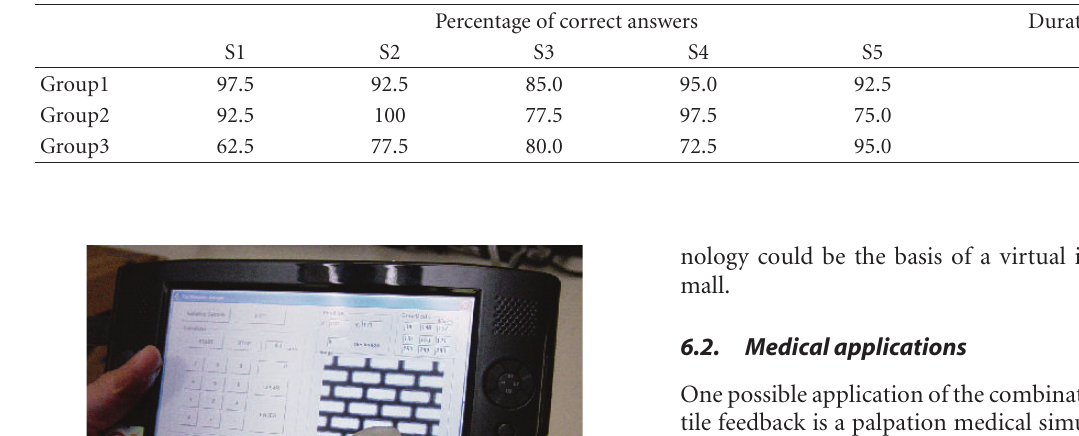
Table 7: Experimental results.